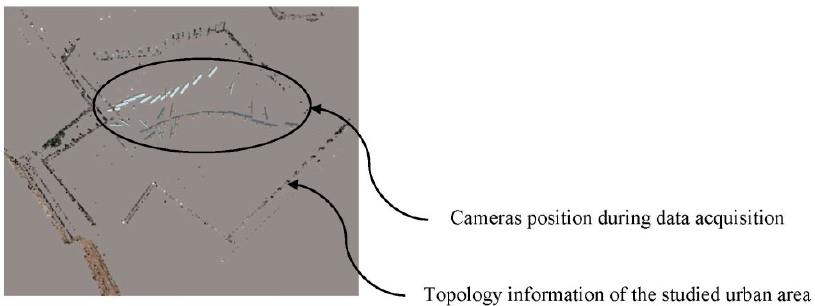
Figure 4. Arrangement of the cameras during the data collection of the urban environment.